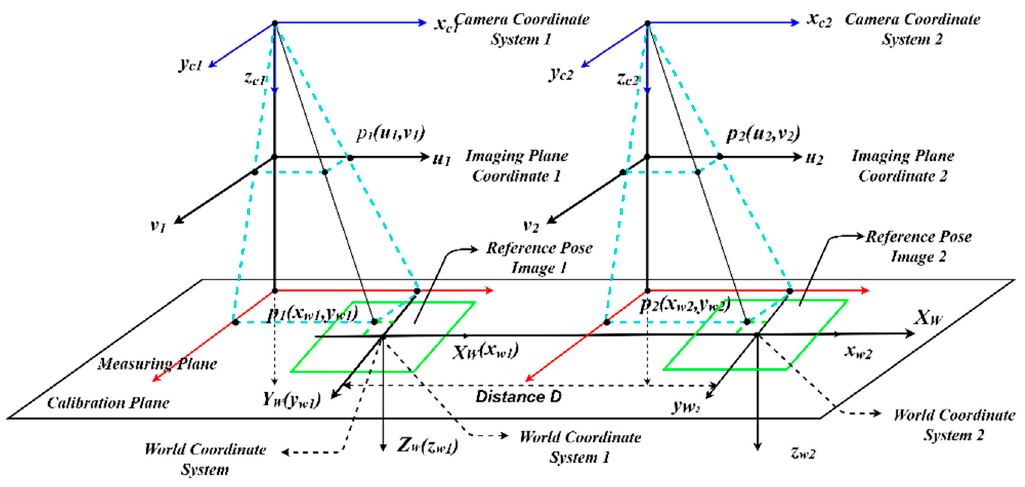
Figure 4. The dual camera measurement system.